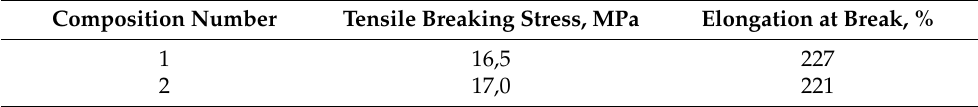
Table 6. Physical and mechanical characteristics of the obtained PVC compositions.